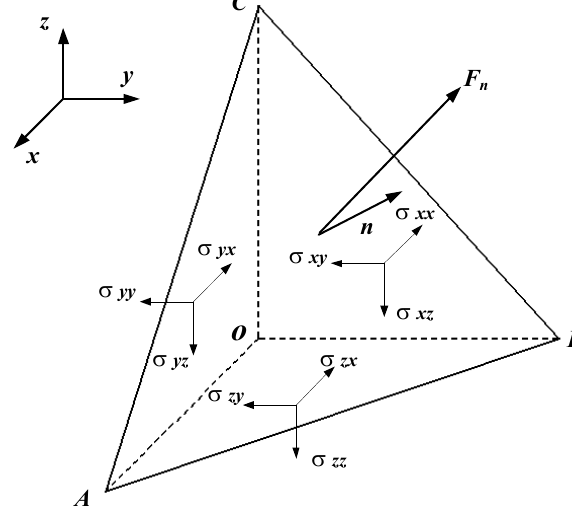
Figure 2. Stress component of an arbitrary elastomer section. Considering the normal direction of an oblique section ABC as the z (cid:48) axis of the new coordinate system, the stress components X v , Y v , and Z v on the section along the original coordinate axis can be expressed as follows: